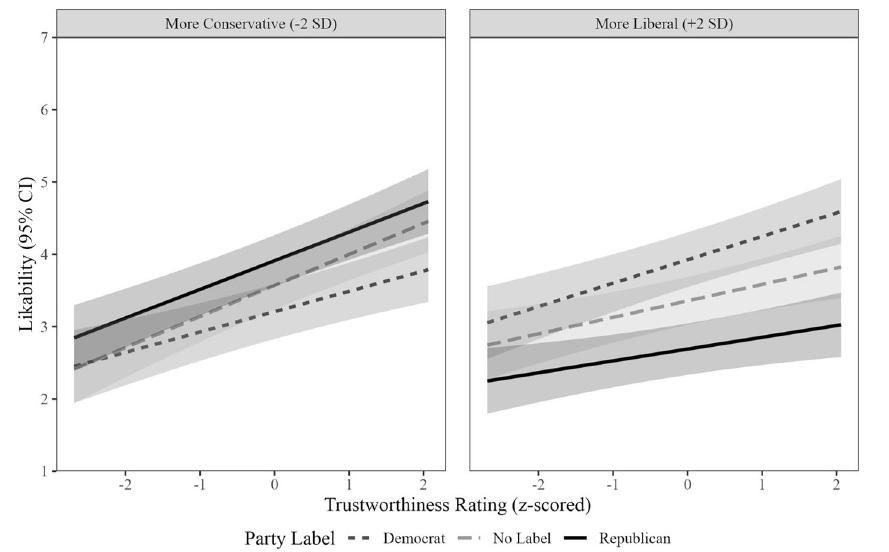
Figure 2. Similar relative to opposing partisan labels accentuated positive facial trustworthiness effects on likability in Experiment 1.